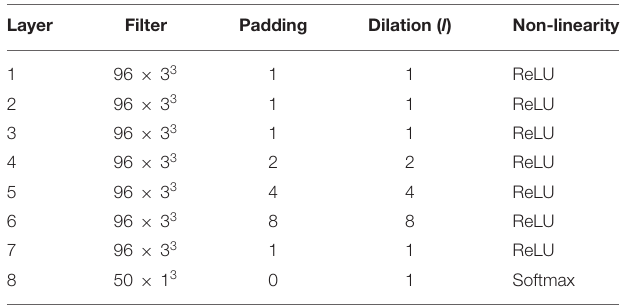
TABLE 1 | The number of examples used from different datasets. Dataset